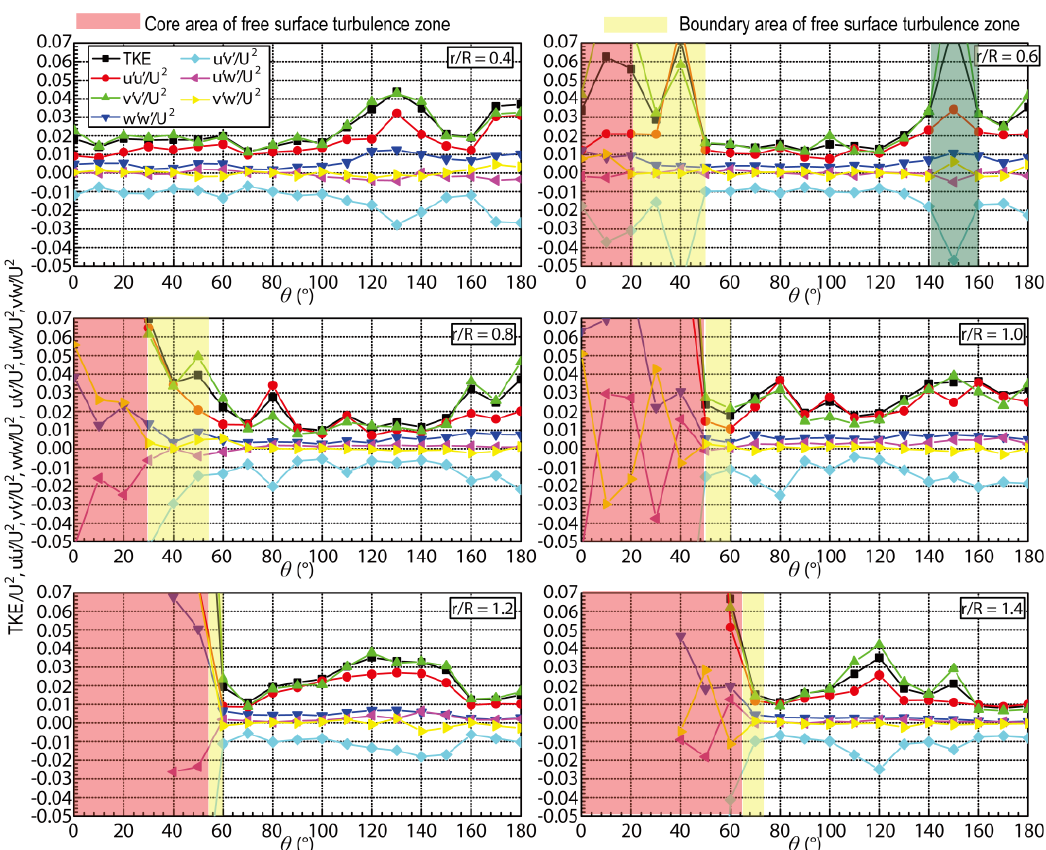
Figure 12. Turbulence statistics profiles at each radius in the propeller region under the ballast